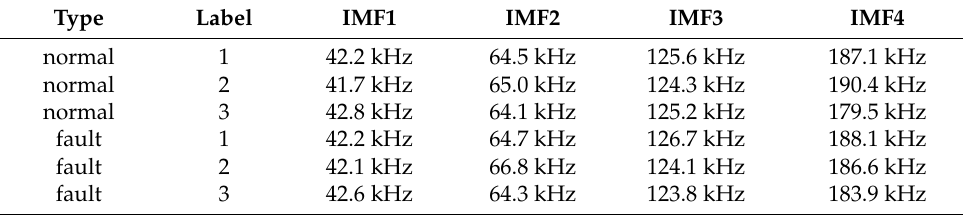
Table 2. K = 4, the center frequency of IMFs after VMD of multiple sets of data.